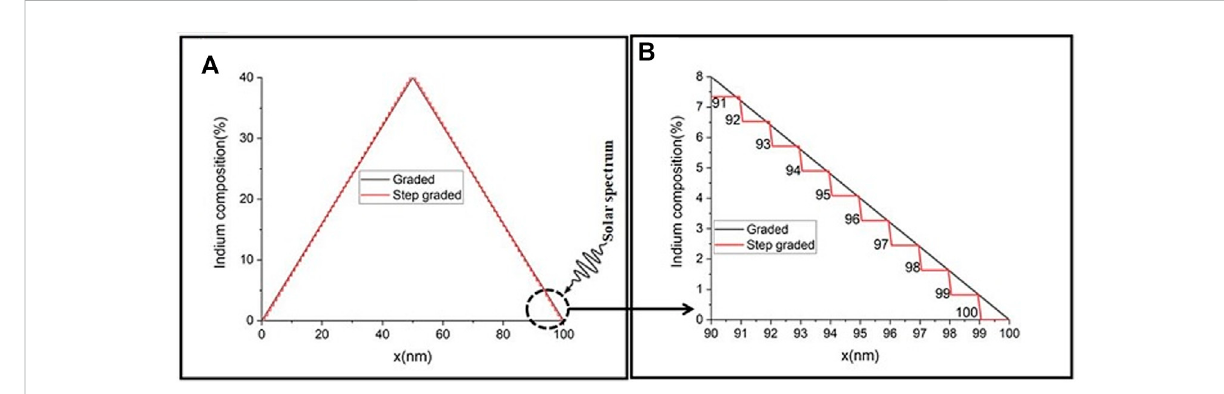
FIGURE 2 (A) Changing the graded structure to step-graded structure for calculating the generation rate in nextnano3. Direction of the solar spectrum and hitting position to the structure is shown as well. (B) Zoom in for 90 – 100 nm to show converting graded to step-graded structure in which the number of each layer is given in addition to the layer when light passes through the